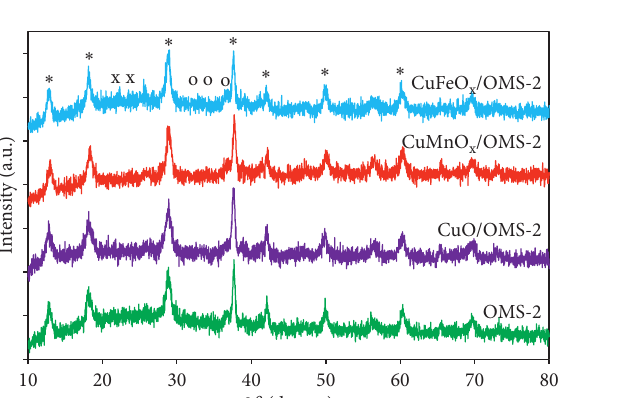
∗ : cryptomelane, o copper oxide, and x